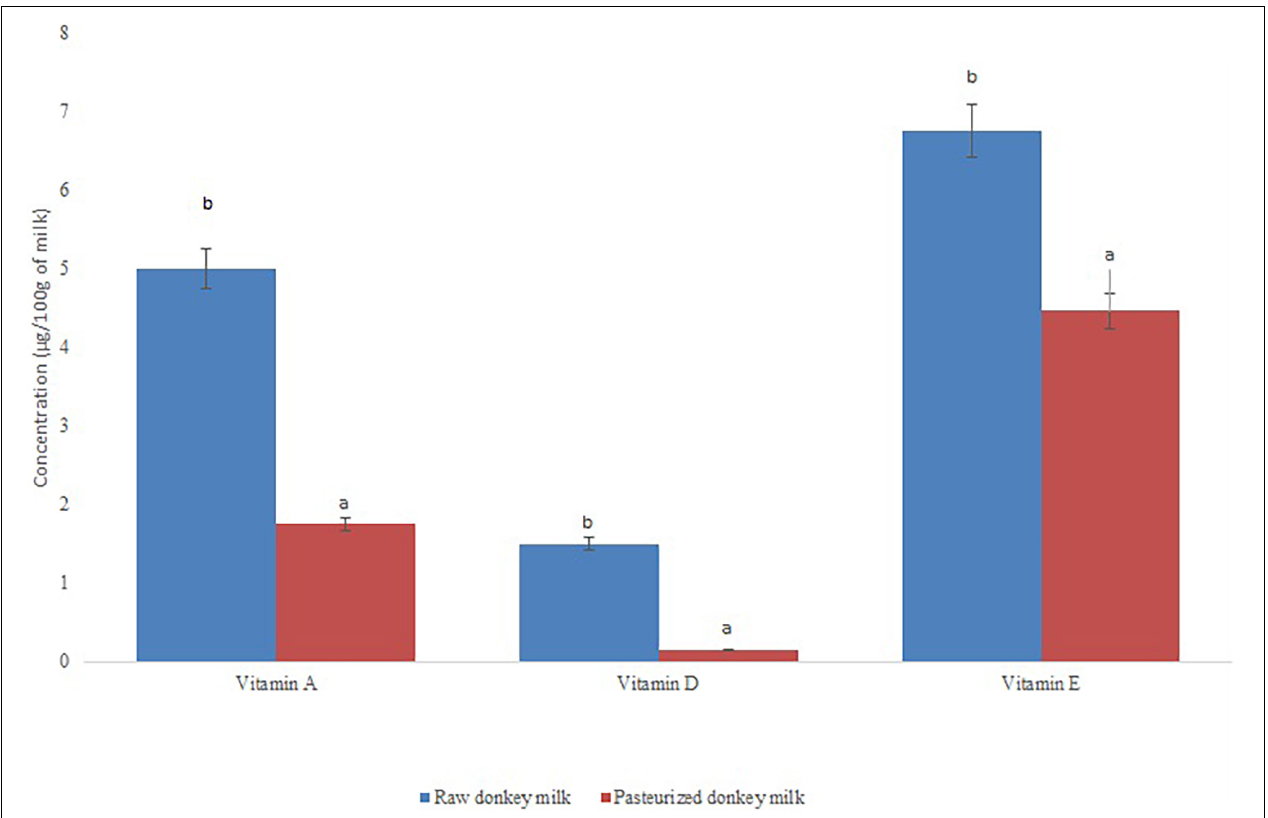
FIGURE 2 | Concentration of fat-soluble vitamins in raw and pasteurised milk from the Zamorano-Leonese breed. Different letters mean significant differences between samples ( p < 0.05).